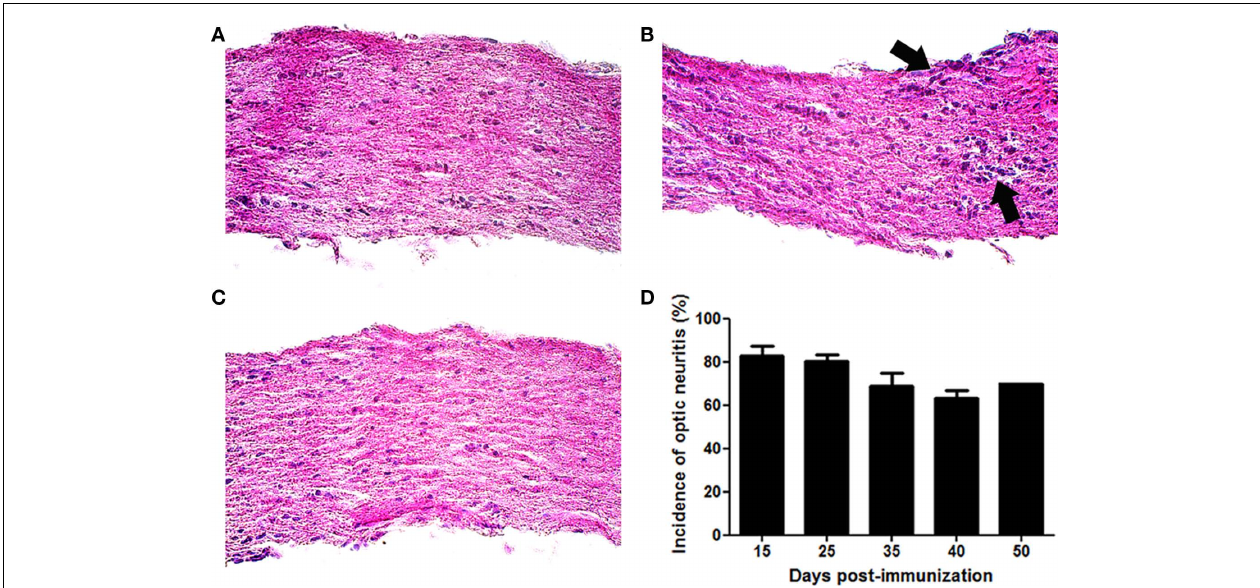
with ON. (C) EAE optic nerve without ON. (D) Most optic nerves develop inflammation by day 15 post-immunization.The percentage of eyes with optic nerve inflammation is shown. Data represent the average (mean ± SEM) incidence of ON at each time point ( n = 3–4 separate experiments/time point, except day 50 which represents a single experiment). Photographs (A–C) shown at original magnification ×